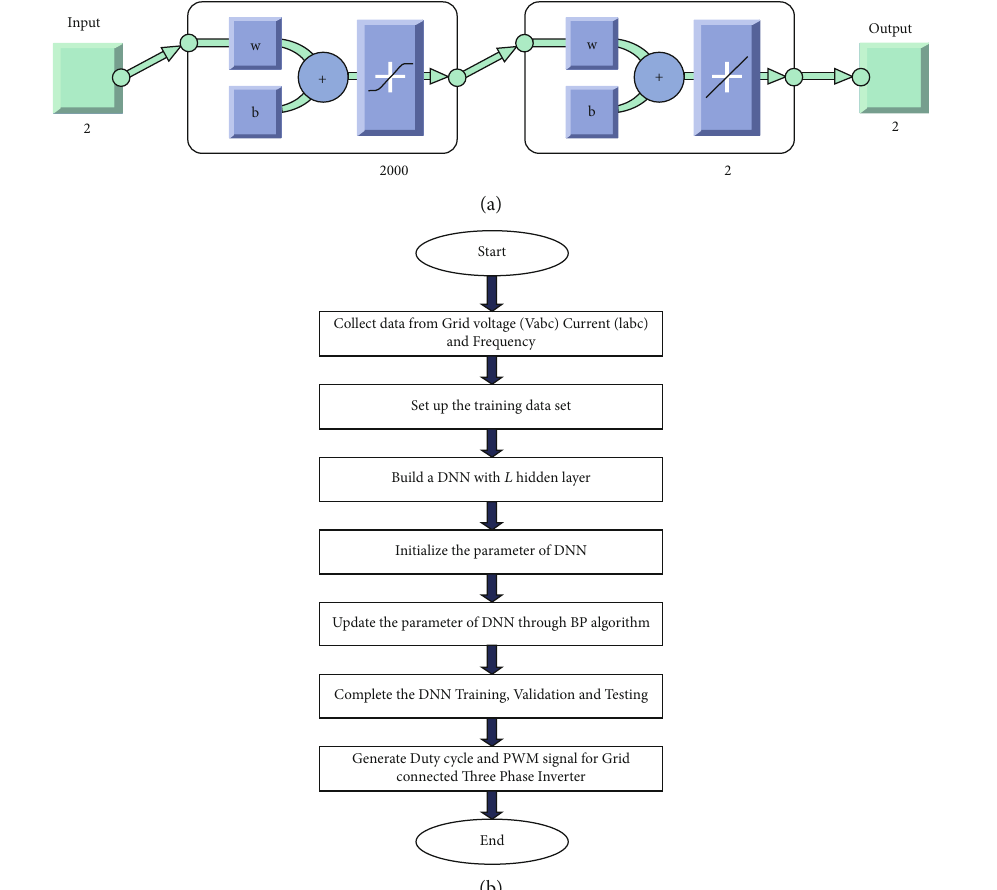
Figure 24: (a) DNN model of a current regulator for smart inverters. (b) Flow chart of DNN model of a current regulator for smart